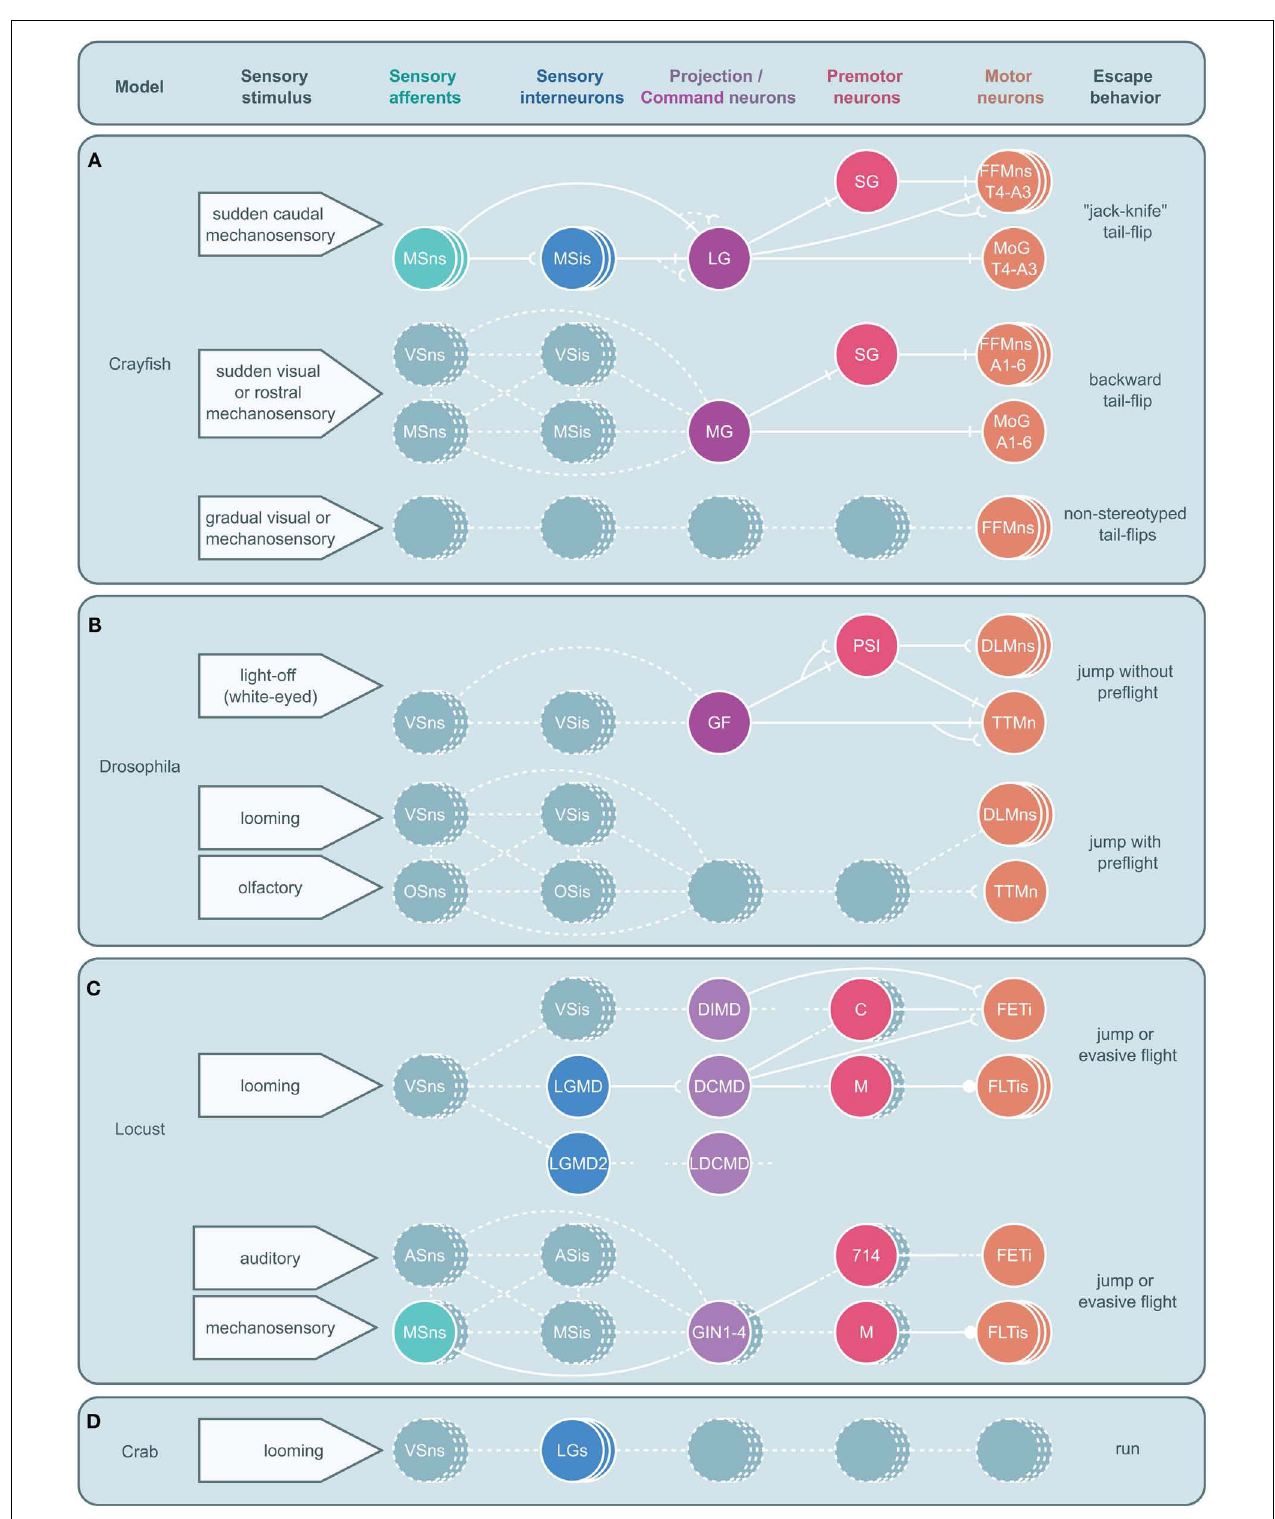
sensory interneurons, projection (ascending or descending) or command neurons, premotor neurons, and motor neurons with associated sensory